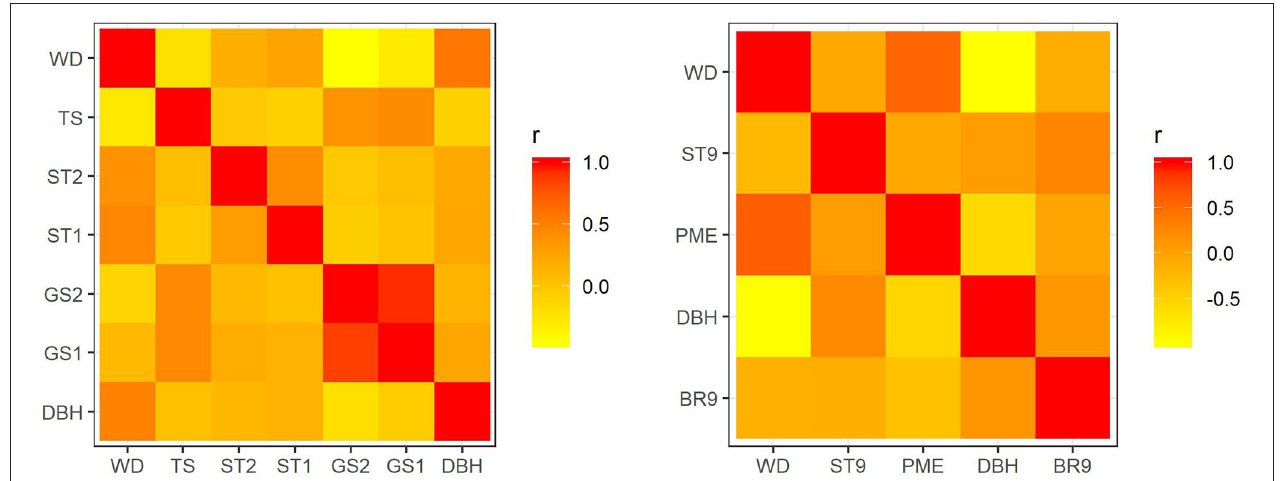
FIGURE 1 | Genetic correlations using variance components and covariances inferred from use of a sib-ship reconstruction-based multivariate model (MVBLUP) (below diagonals) and marker-based relationship matrix (MVGBLUP) (above diagonals) in the E. nitens population (left plot) and using variance components and covariances inferred from use of a pedigree-based multivariate model (MVBLUP) (below diagonals) and marker-based relationship matrix (MVGBLUP) (above diagonals) in the P. radiata population (right